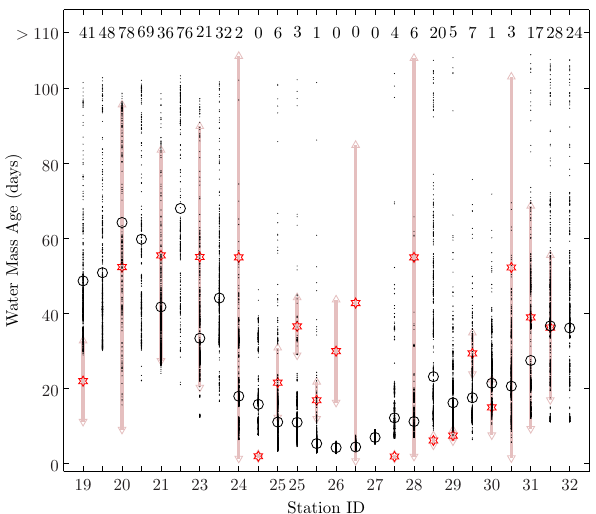
Fig. 5. Ra-based (red) and oceanographic-model-based (black) wa- ter mass age at each station. The mean Ra-based age is shown by red stars; pink line segments show the Ra age standard deviation. The mean model-based water age is indicated by black circles, while the ages of individual water parcels (an indication of the range of val- ues) are shown as small black dots. The percentage of water parcels with model-based ages > 110 days is indicated near the top of the plot for each